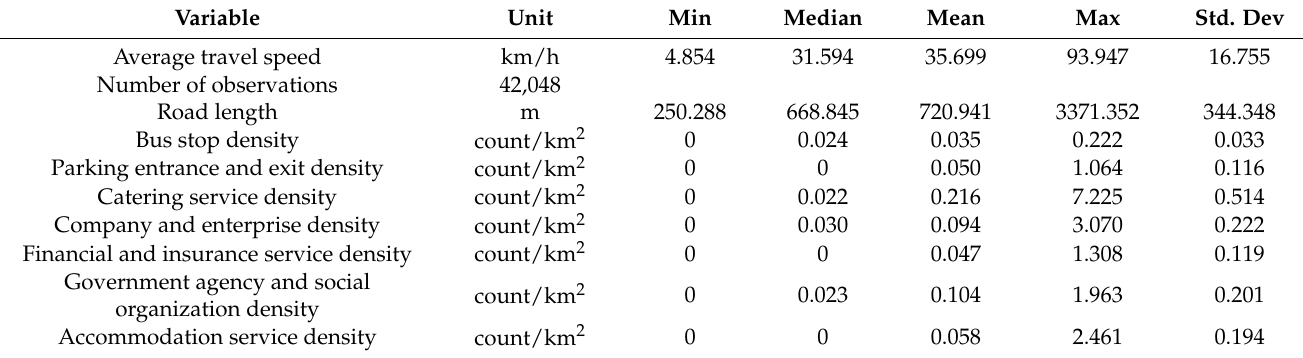
Table 1. Descriptive statistics of the